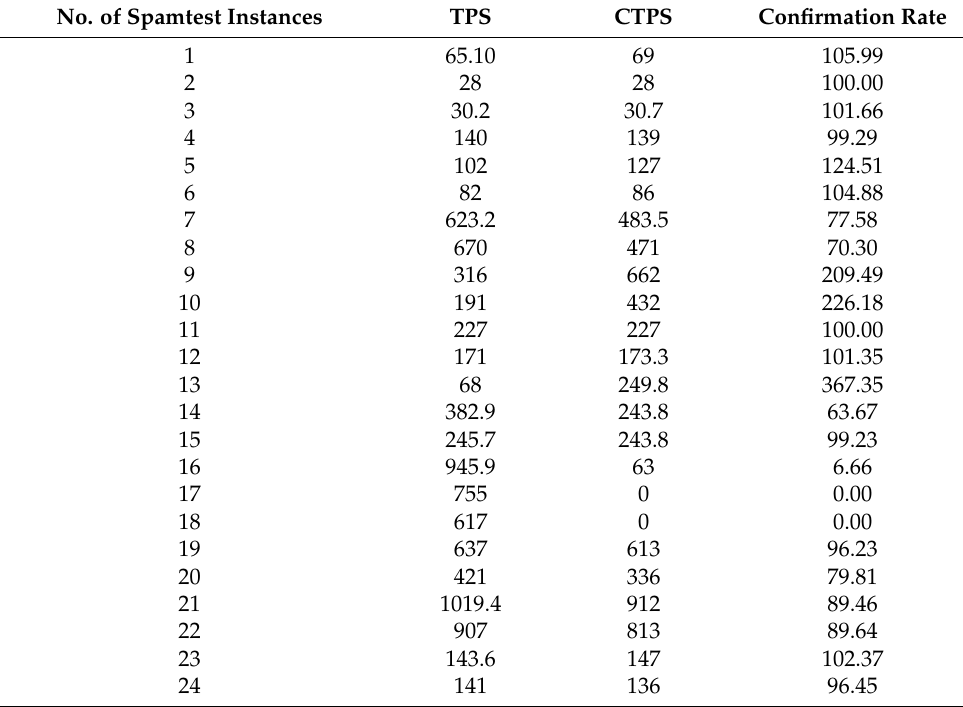
Figure 20. TPS versus Confirmation Rate. Table 5. Result of the community spam test observed at our hornet node .